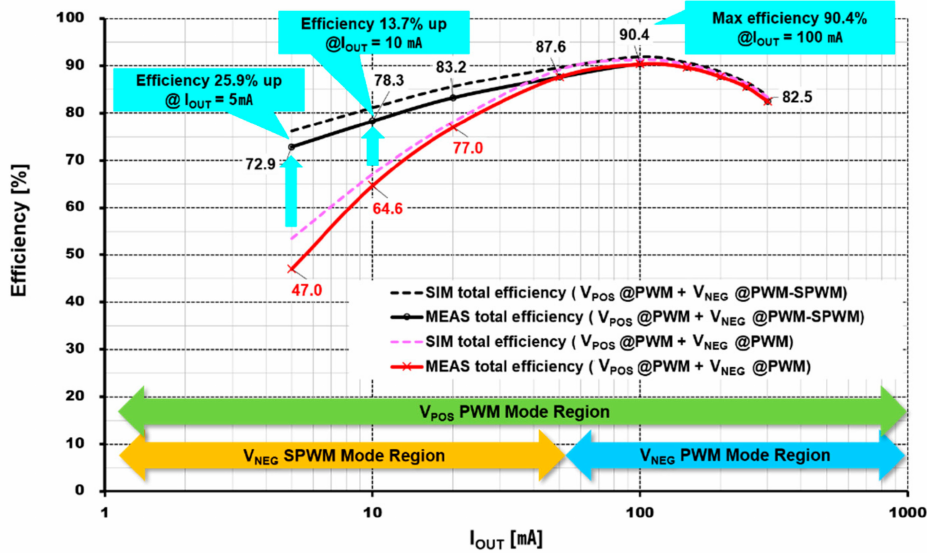
Figure 15. Measurement results of power